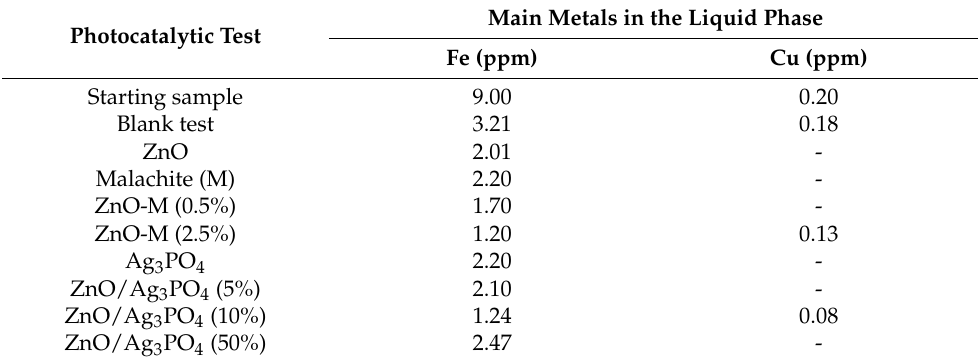
Table 6. Iron and copper removal from coal mining wastewater after 120 min of photocatalytic treatment. Photocatalytic